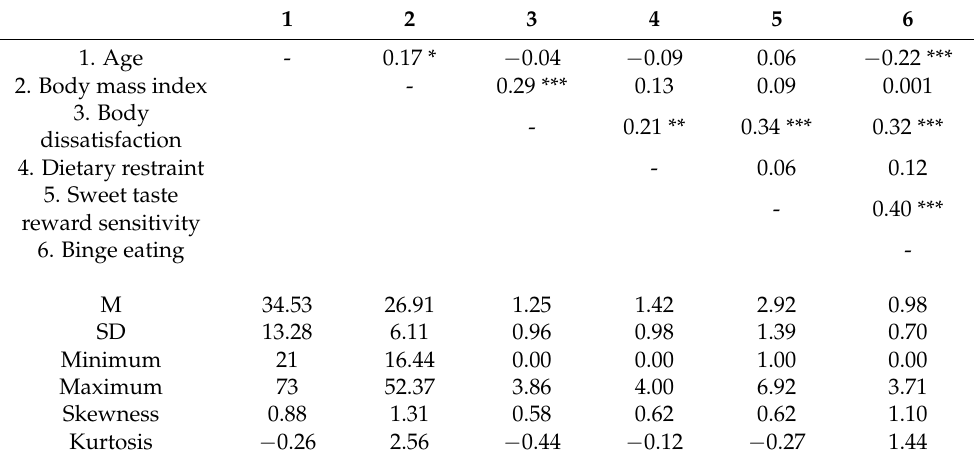
Table 1. Pearson Correlations and Descriptive Statistics of Study Variables.